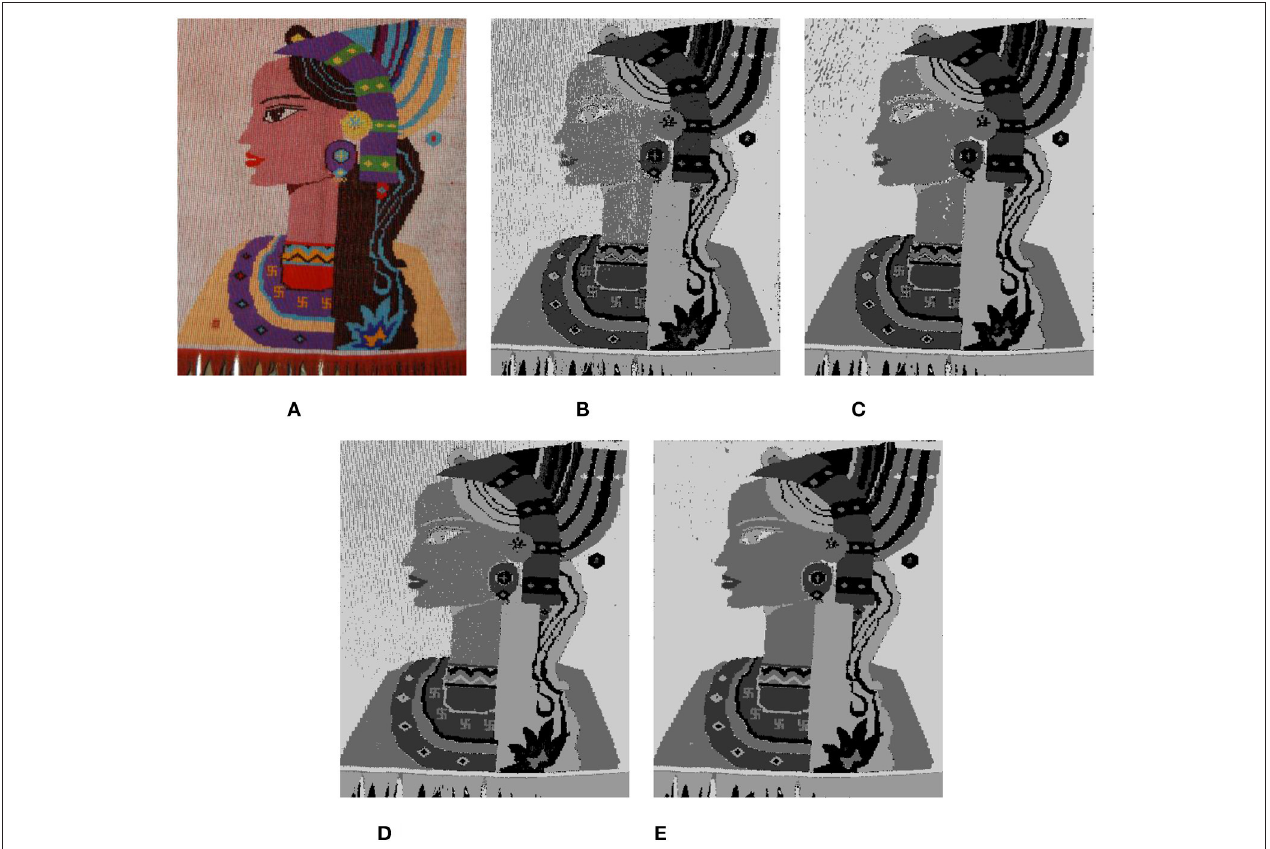
FIGURE 4 | Optimization of clustering results. (A) Image: Original. (B) GMM, K = 5. (C) Vote_Optimization: GMM + Vote_Optimization. (D) GMM + DenseCRF. (E) GMM + DenseCRF + Vote_Optimization.